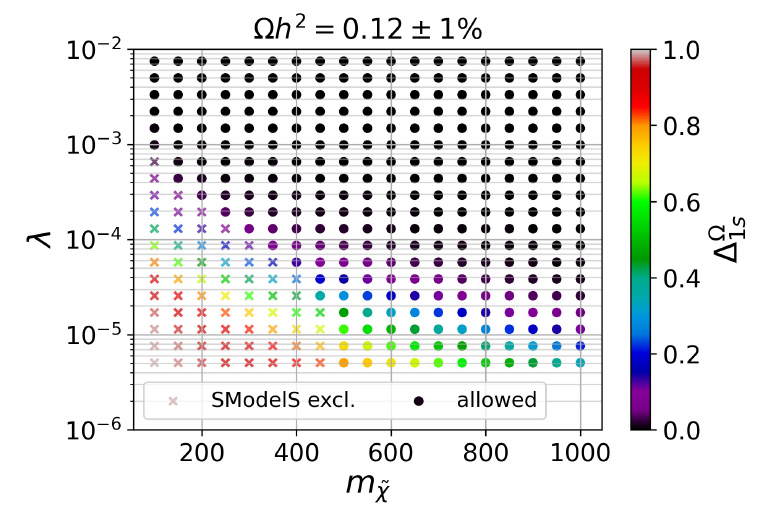
Figure 5: Scan result in the plane of λ versus DM mass m mass parameter M is adjusted such that Ω h 2 = 0.12. The colour scale indicates ∆ Ω as defined in Eq. (27). Full-coloured points pass collider constraints, crosses are excluded by the disappearing track results in SM ODEL S